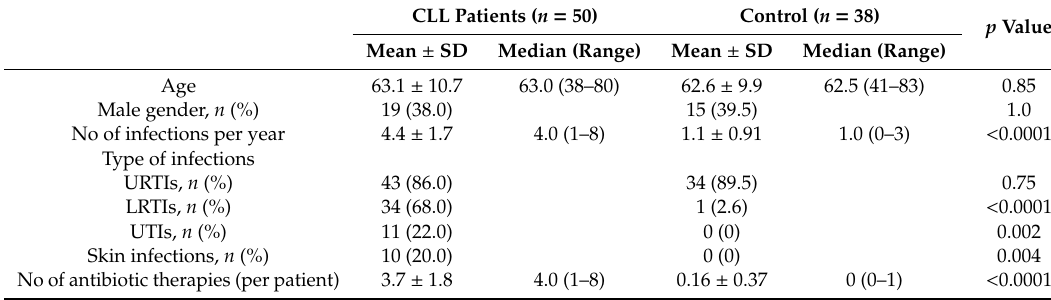
Table 1. Characteristics of the cohort